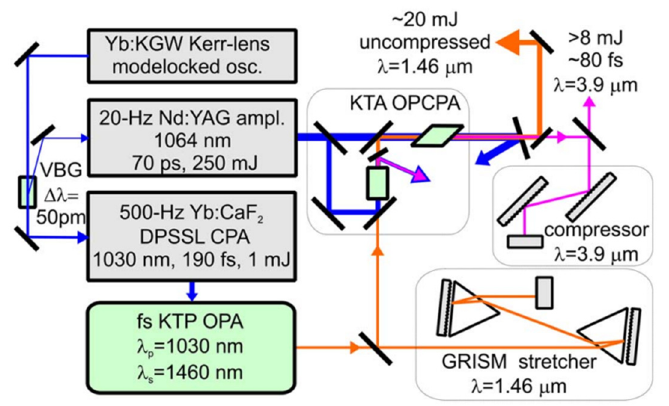
Figure 8. Layout of the 3.9 µ m OPCPA system. Reprinted with permission from [52]. In the 3–4 µ m band, J. Biegert’s team demonstrated a high-average-power MIR OPCPA with 21 W output power at a central wavelength of 3.25 µ m and a repetition rate of 160 kHz [49]. As shown in Figure 9, the MIR seed at 3.25 µ m was generated by a two-color fiber front-end in combination with a DFG stage. Afterwards, the MIR pulses were stretched and consecutively amplified in a preamplifier and two booster amplifiers. As it was being pumped, a Nd:YVO 4 -based master oscillator power amplifier (MOPA) was employed, providing 1.1 mJ, 9 ps pulses at a 1064 nm wavelength at a 160 kHz repetition rate.